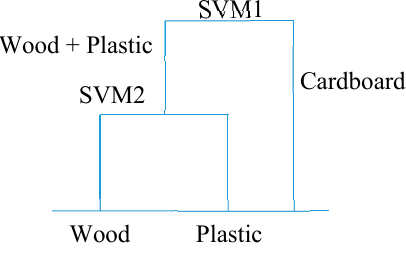
Figure 7. A decision-tree-based support vector machine (SVM) generated for the three classes of cardboard, wood, and plastic.